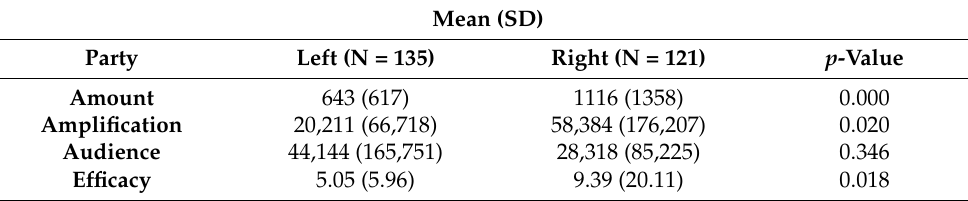
Table 5. Mean amount, amplification, audience and efficacy by political spectrum (left/right).